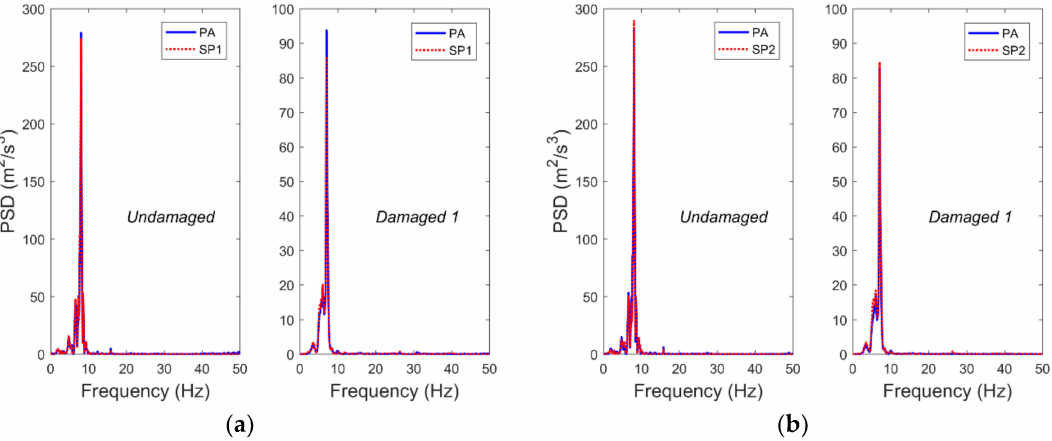
Figure 4. The acceleration time-history responses, as collected by the piezoelectric accelerometers (PAs) and smartphones (SPs) for four damage cases subjected to Nr-1 cm excitation, are compared. Representative results from ( a ) frame 1 and ( b ) frame 2 in the undamaged and damaged 1 cases, as well as ( c ) frame 1 and ( d ) frame 2 in the damaged 2 and damaged 3 cases are